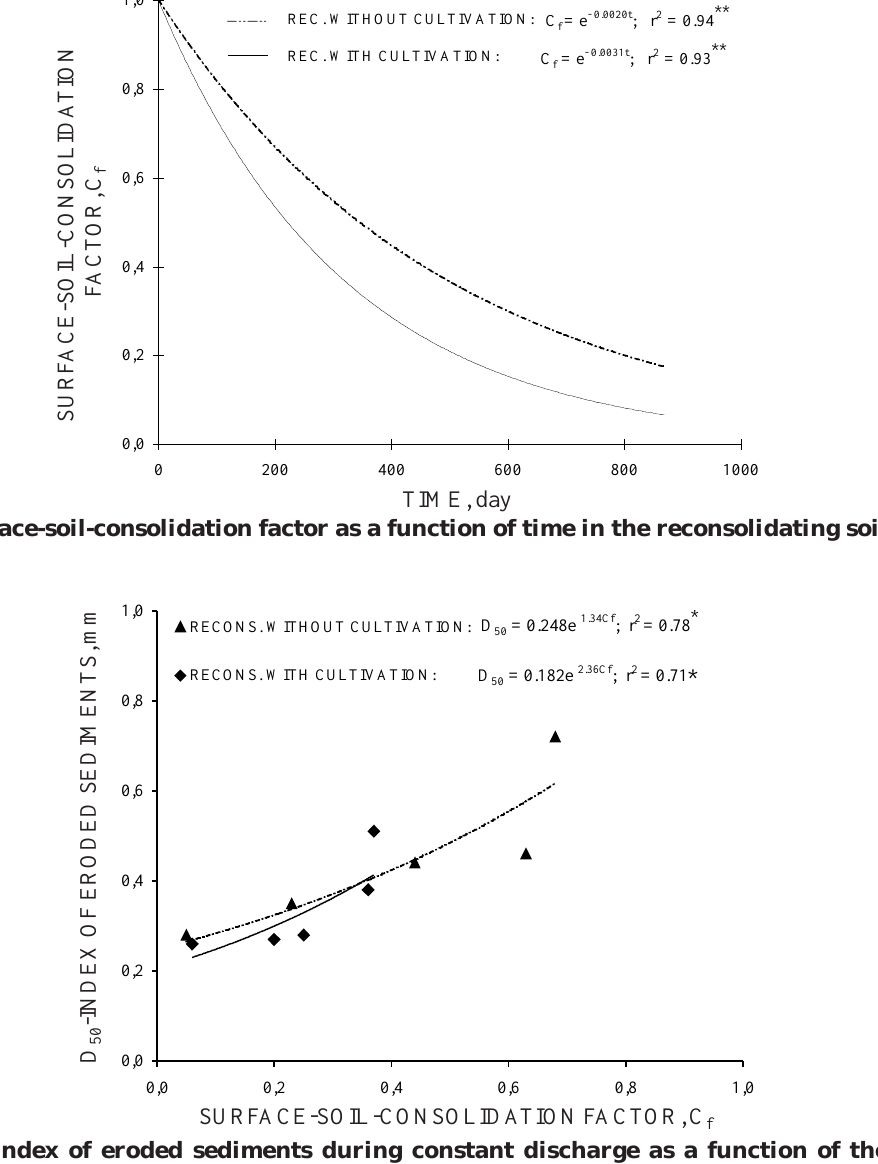
Figure 8. D -index of eroded sediments during constant discharge as a function of the surface-soil- 50 consolidation factor in the reconsolidating soil treatments.